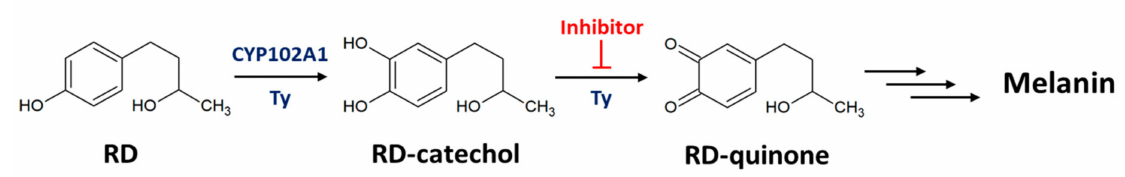
Figure 1. Scheme for rhododendrol (RD)-catechol production using cytochrome (CYP)102A1 and tyrosinase